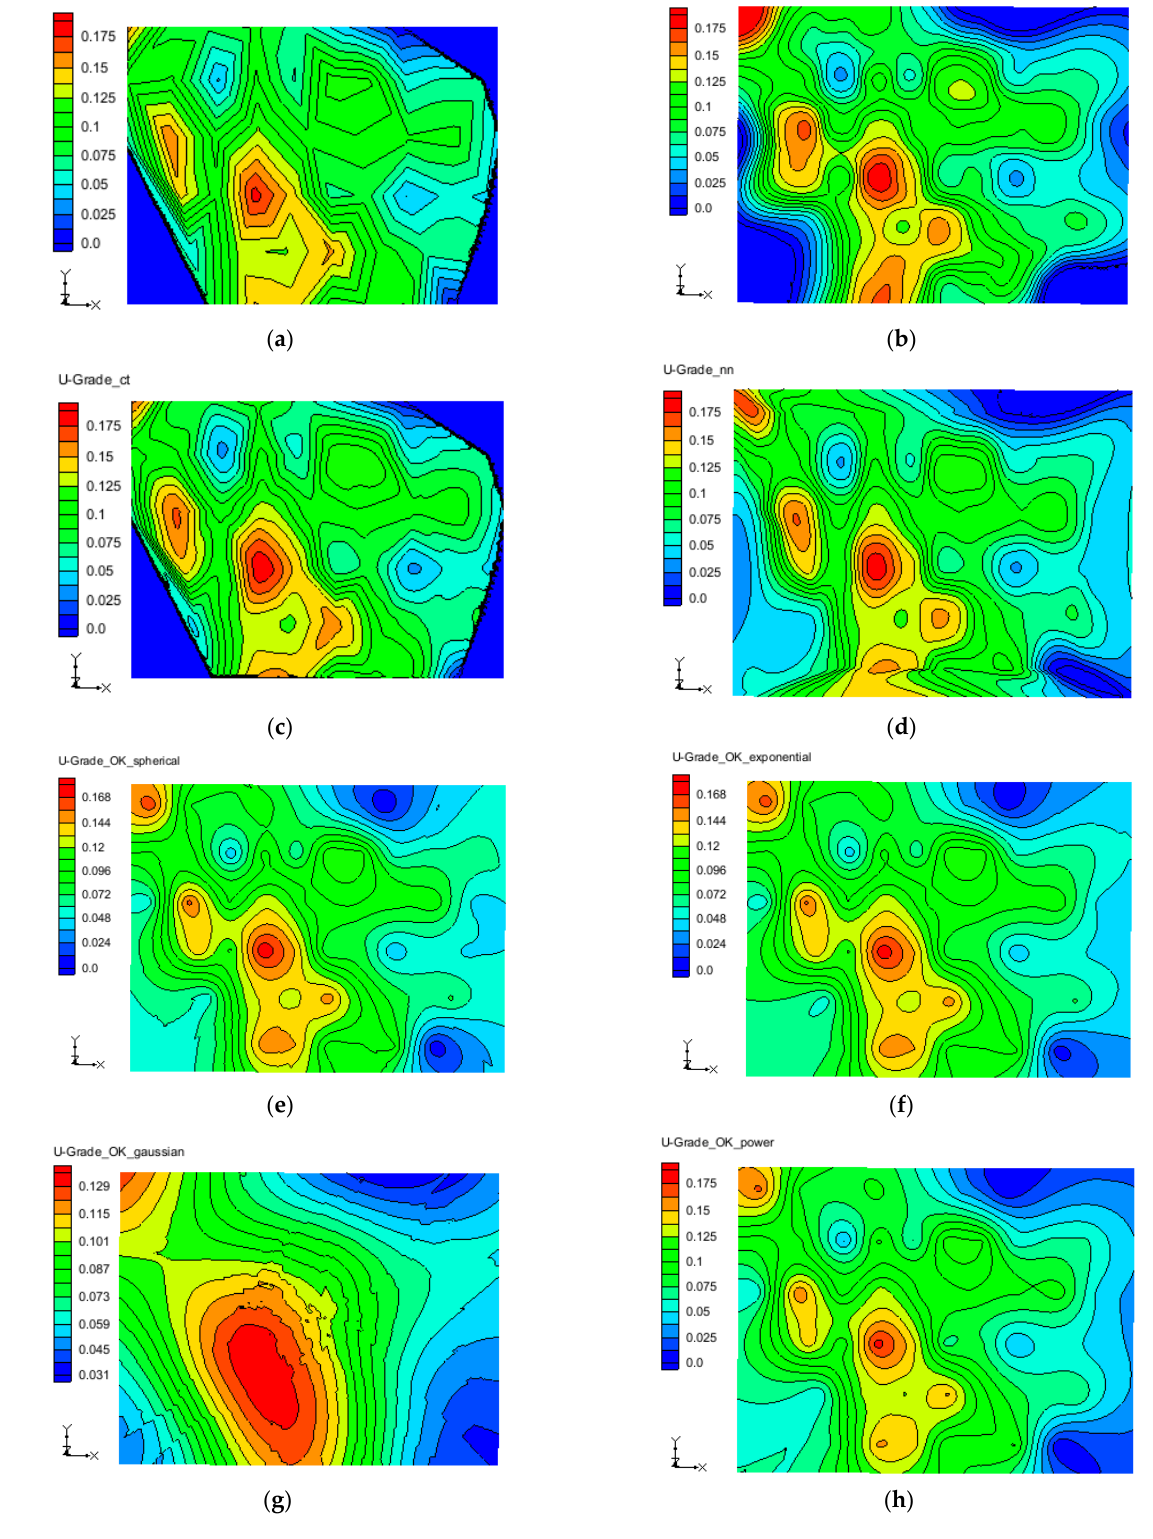
Figure 2. Distribution characteristics of uranium grade under different interpolation methods. ( a ) Lin- ear; ( b ) IDW; ( c ) CT; ( d ) NN; ( e ) OK(spherical); ( f ) OK(exponential); ( g ) OK(gaussian); ( h )